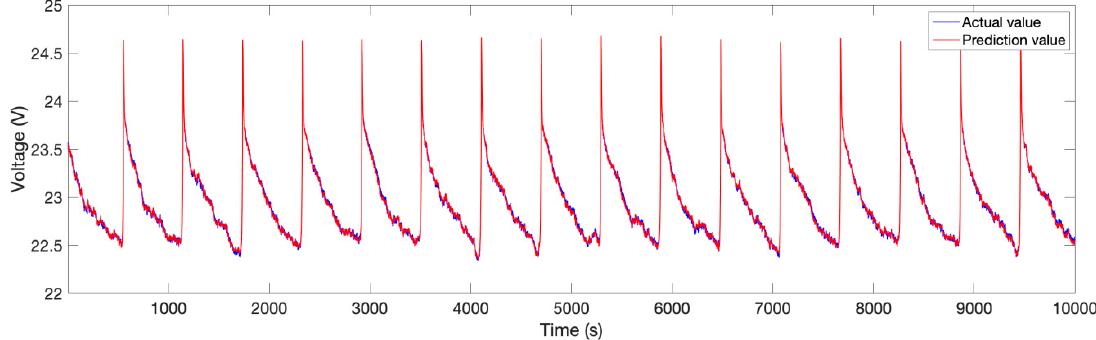
Figure 5. Partial prediction results in 2014 data.